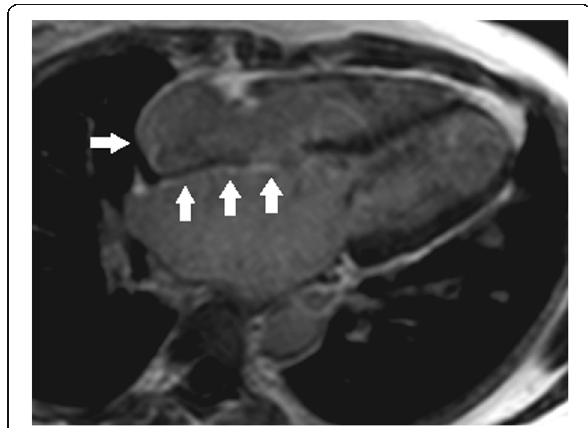
Fig. 4 DE-MRI showing LA enlargement and moderate atrial fibrosis (involves the entire septum and the right atrium, arrows)